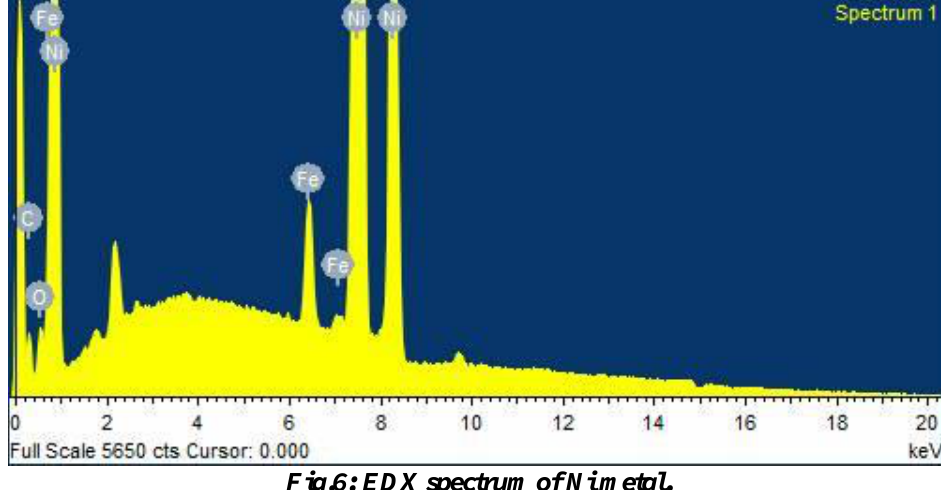
Fig.6: EDX spectrum of Ni metal. Table 2: Elements analysis of the nickel sample base on the EDX spectrum.